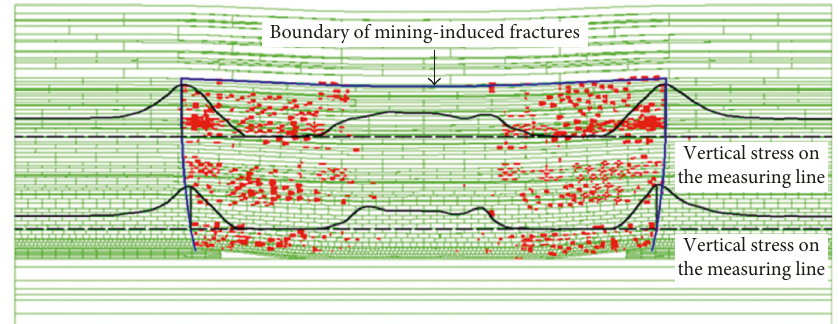
Figure 5: Distribution of vertical stress and mining-induced fractures after mining of a coal